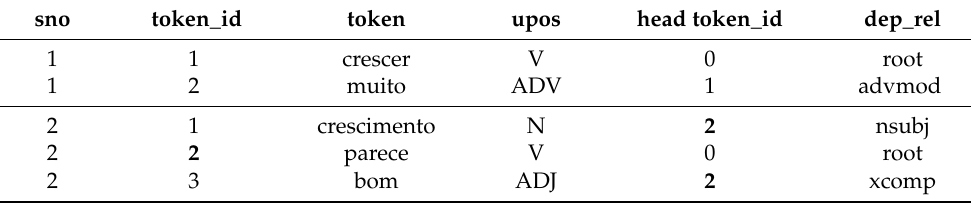
Table 4. Dependencies between tokens provided by the dependency parser.